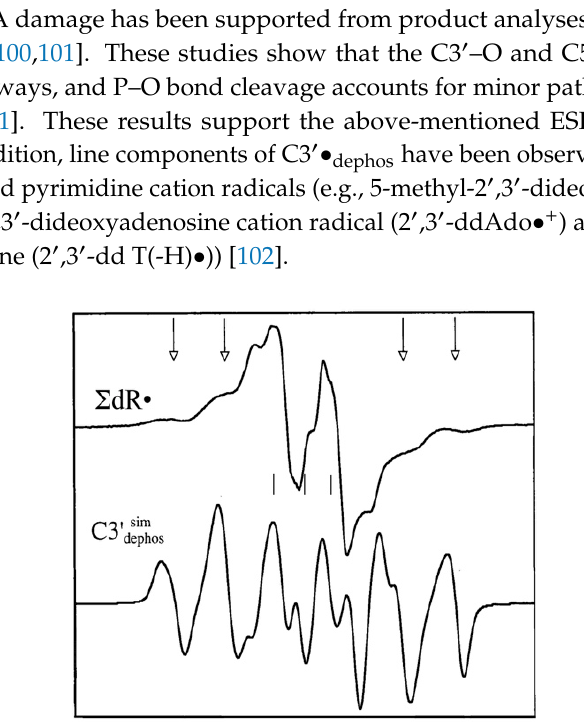
Figure 12. Experimental ESR spectrum of sugar radicals in Kr-86 ion beam irradiated DNA ( ∑ dR•) and simulated spectrum of C3´• dephos using parameters given in narrative. The arrows indicate the positions of the outer four lines of C3´• dephos in the experimental spectrum (top). Adapted from reference [98] with permission from Radiation Research, 2019 Radiation Research Society.